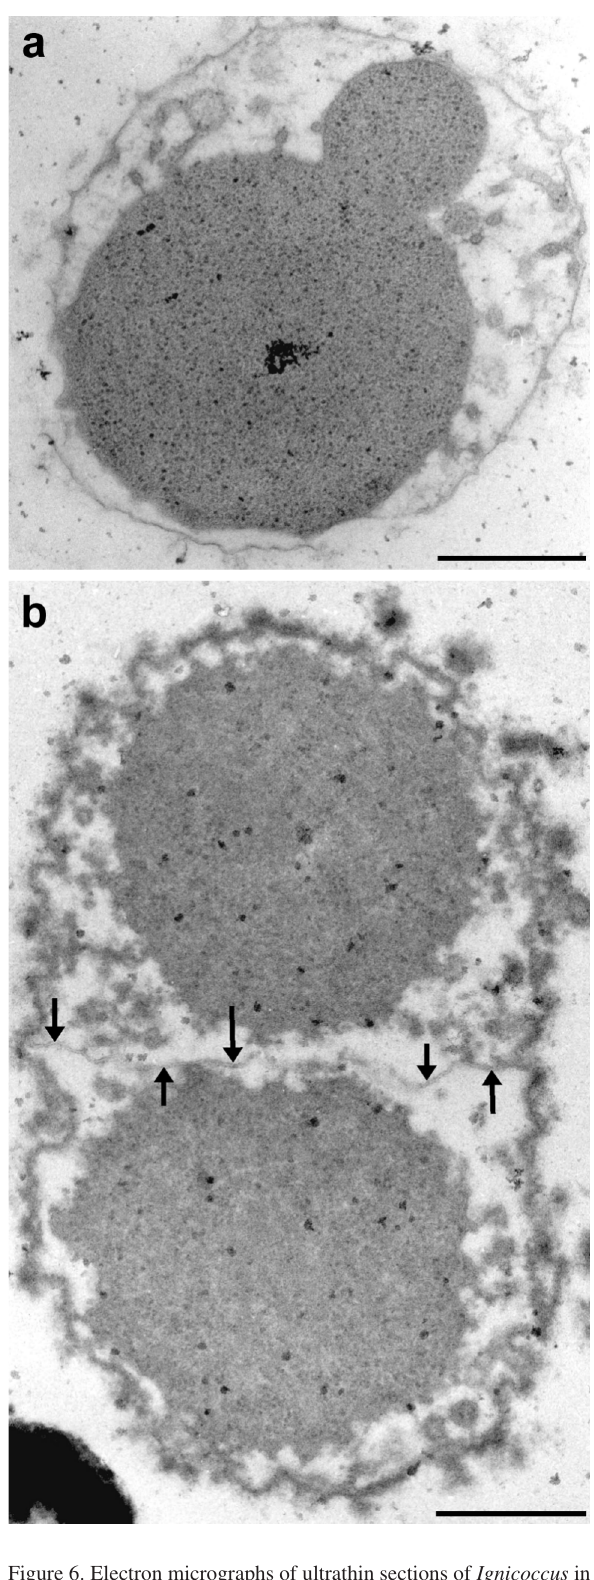
Figure 6. Electron micrographs of ultrathin sections of Ignicoccus in division, prepared by (a) high-pressure freezing and freeze-substitu- tion, and (b) initial glutaraldehyde fixation and freeze-substitution, and embedding in Epon. Arrows point to the newly synthesized outer membrane between the daughter cells; bar = 0.5